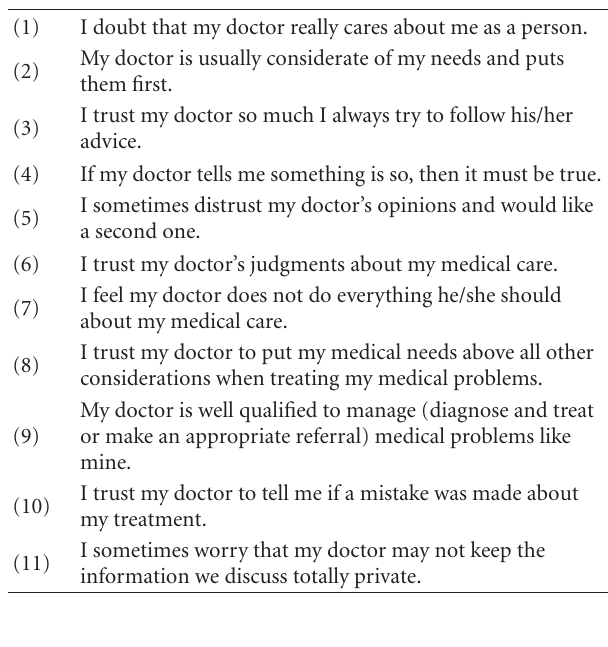
Table 1: Trust in physician scale.